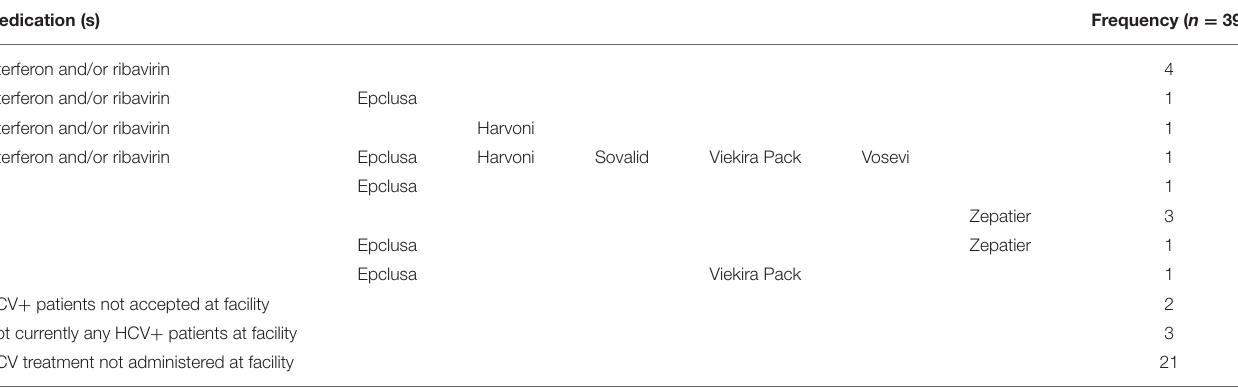
TABLE 6 | Medical director responses regarding the types of medications used by DOPPS 7-China HD units for treating HCV + in their HD patients (China Medical Director HCV survey, 2021). Medication (s)